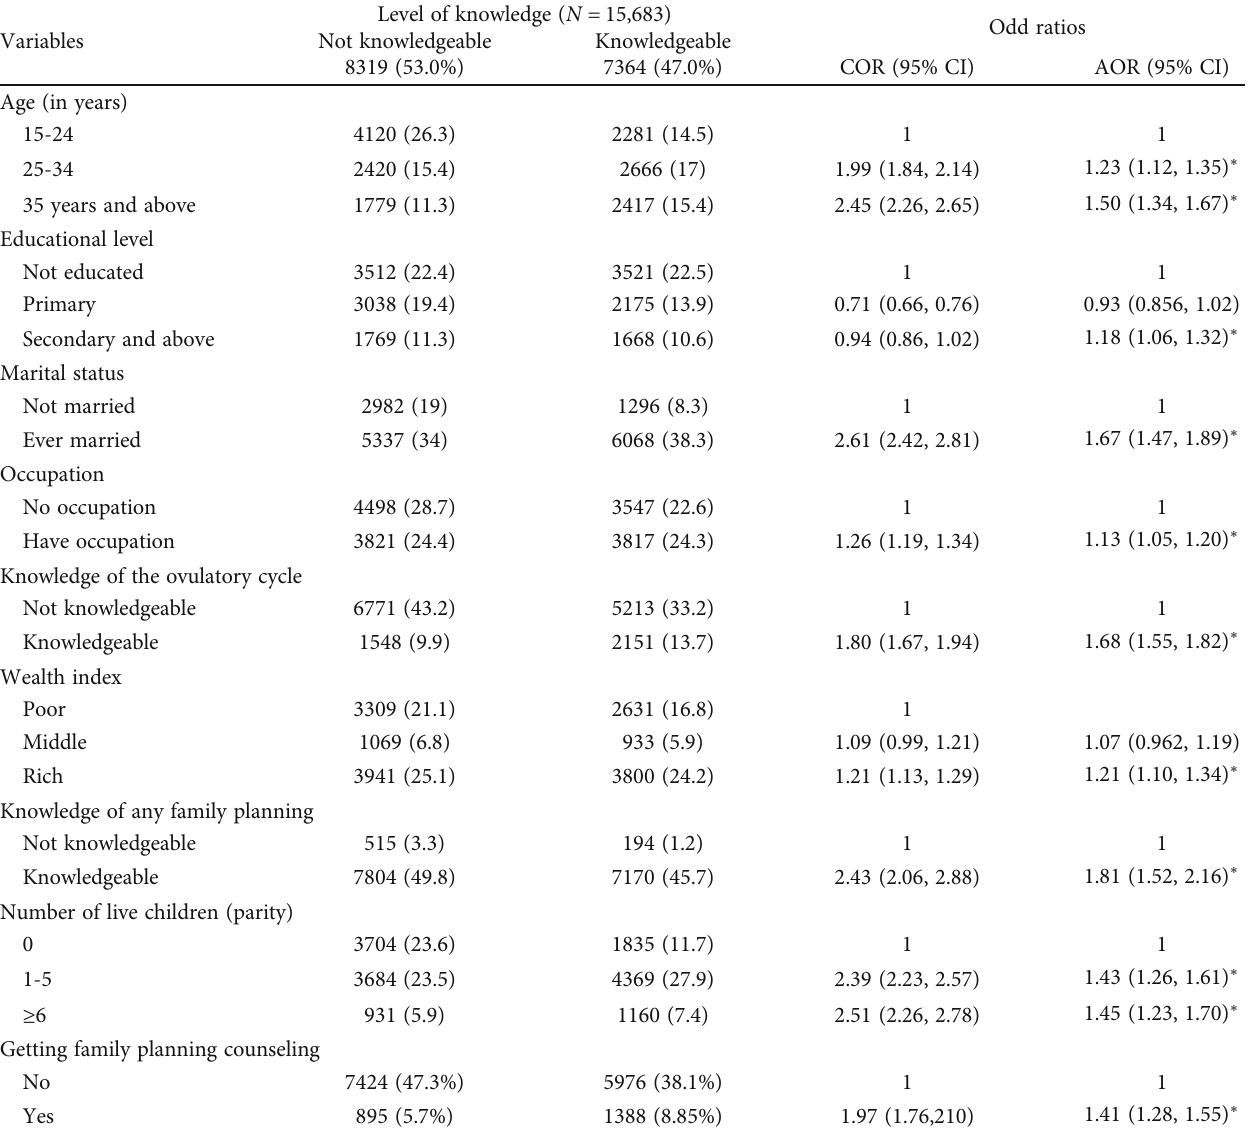
Table 2: Bivariate and multivariable logistic regression on women ’ s knowledge on the possibility of pregnancy after birth but before resumption of the menstrual period and its associated factors: EDHS 2016 data